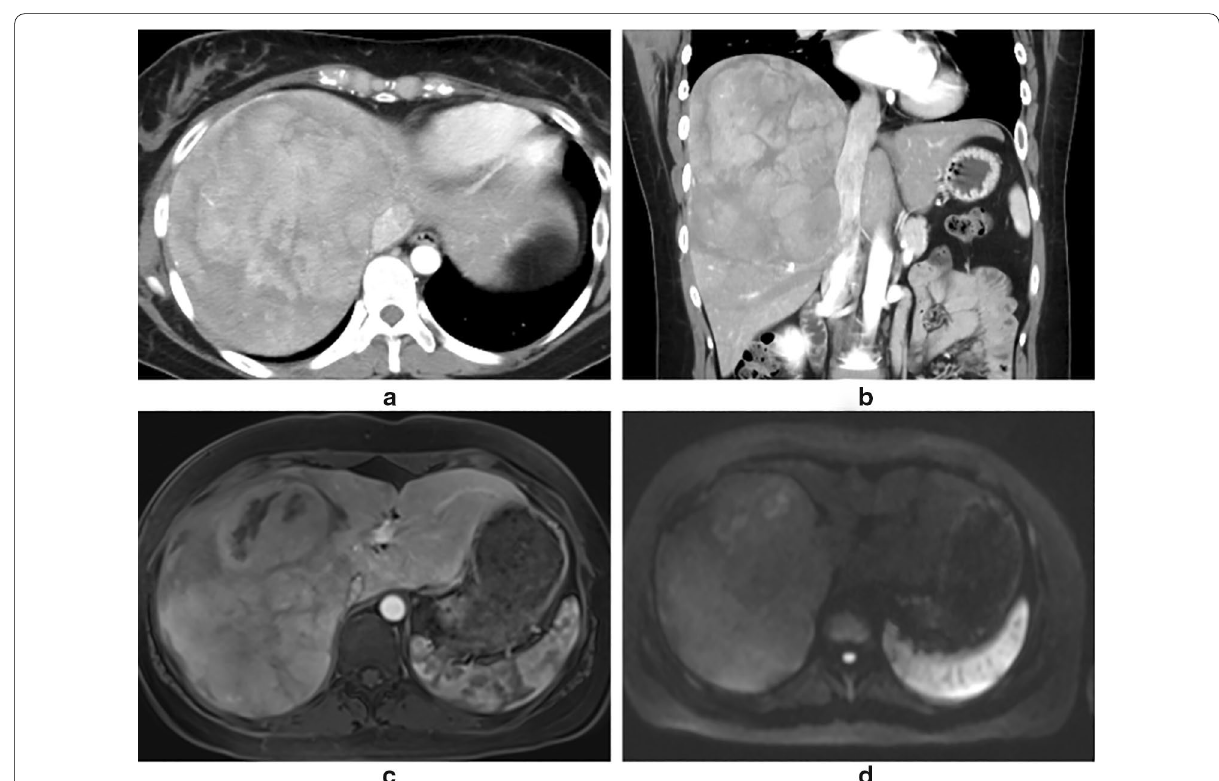
Fig. 1 Enhanced computed tomography (CT) and gadolinium ethoxybenzyl diethylenetriamine pentaacetic acid-enhanced MRI findings CT showed a 150-mm-diameter tumor in the right hepatic lobe: a axial view, b coronal view. MRI showed c . No high intensity is detected compared to the background liver in the diffusion-weighted images ( d )